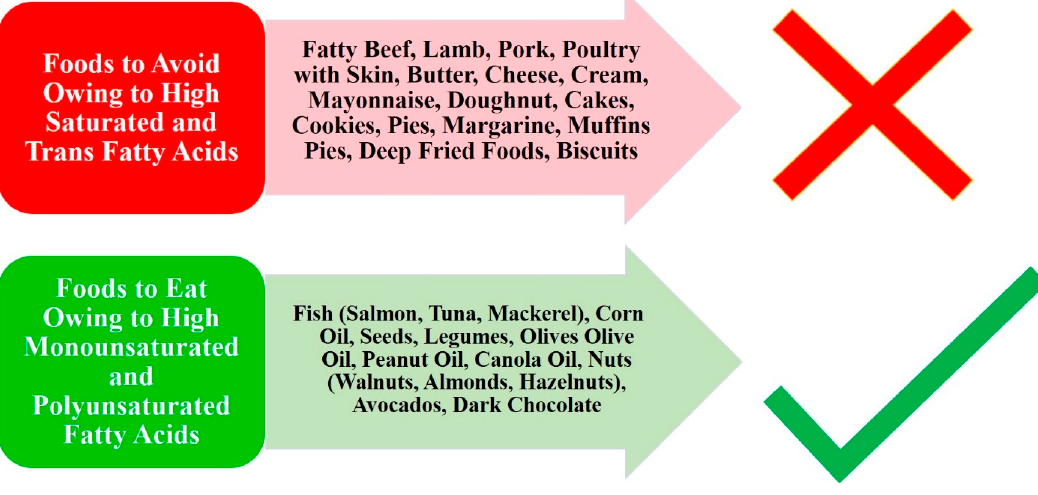
Figure 2. Examples of Dietary Fats.